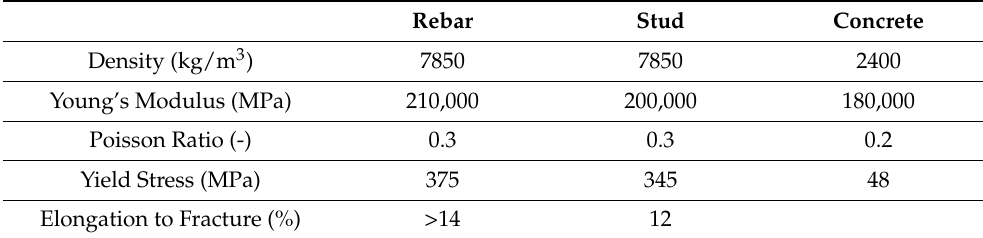
Rebar Rebar Stud